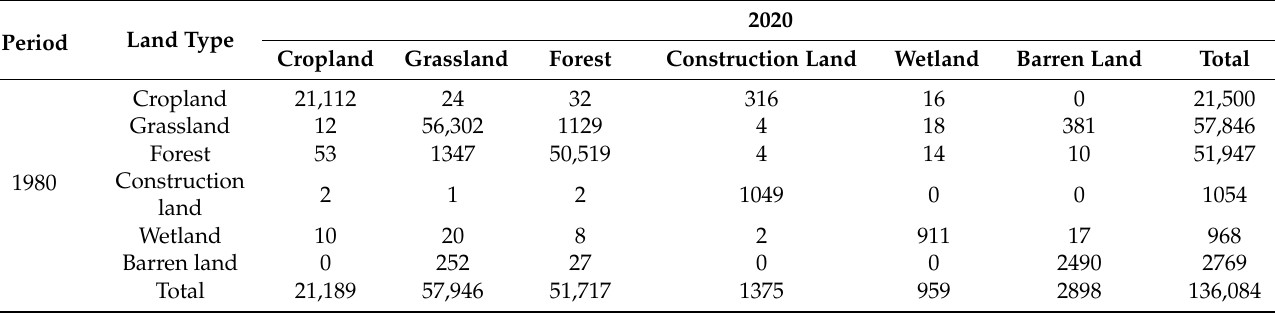
Table 7. Transfer matrix of land use from 1980 to 2020 (km 2